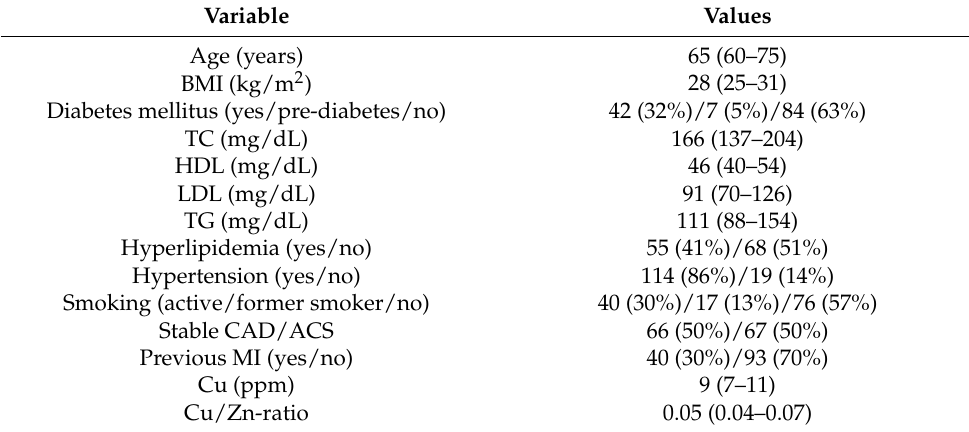
Table 1. Participants’